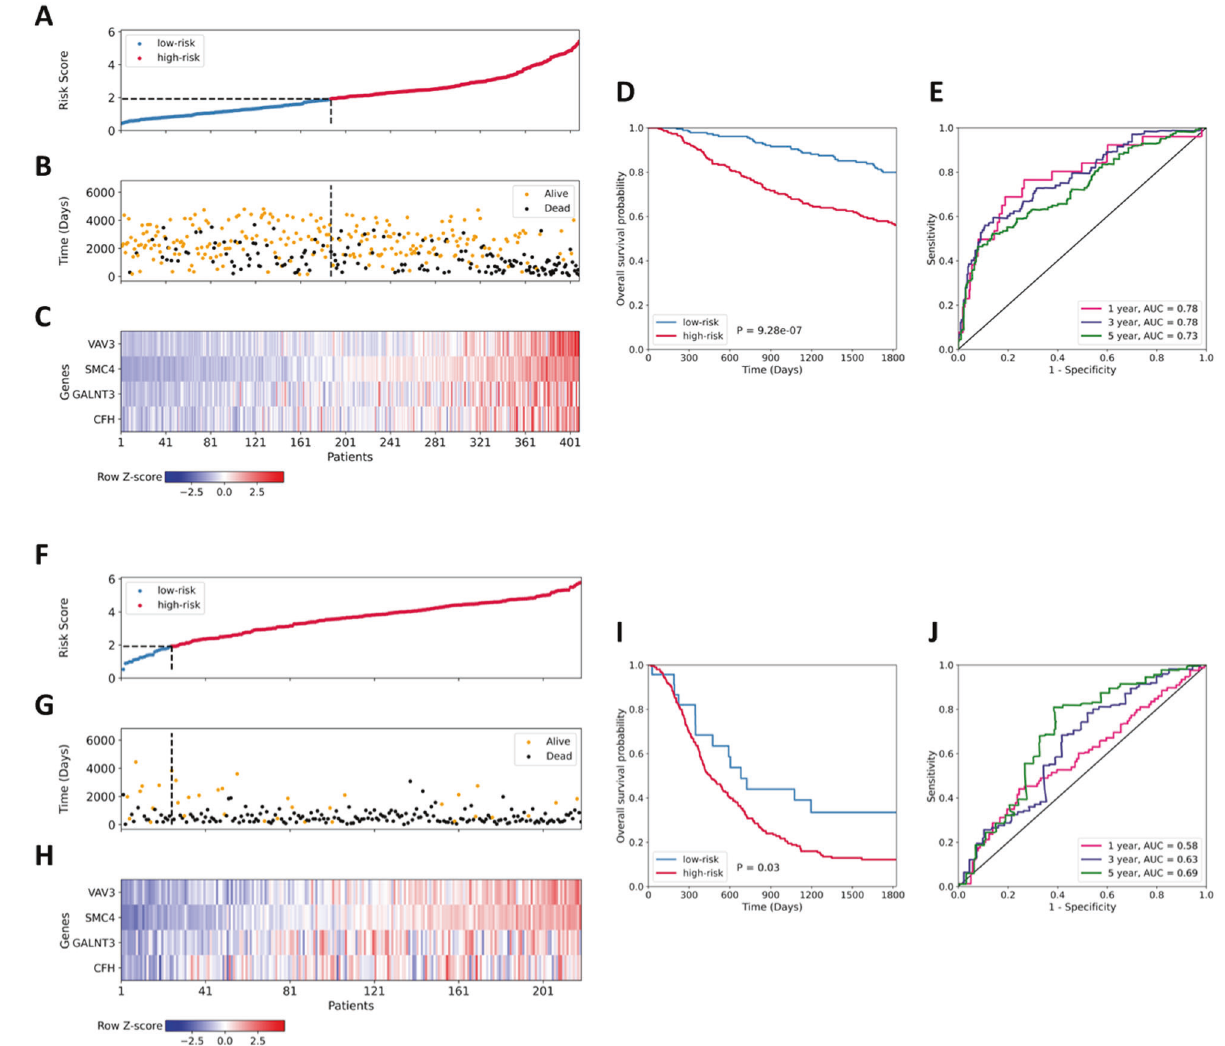
Fig. 7 Validation of the prognostic four-gene signature for overall survival in the CGGA-LGG, TCGA-GBM and CGGA-GBM datasets. A – E Characteristics of the four-gene prognostic signature in the validation CGGA-LGG dataset. A The low- and high-risk scores for each CGGA- LGG patient. B The time to death of patients (black, DEAD) and time until last follow-up of live patients (orange, ALIVE) from the CGGA-LGG dataset. C Heatmap of gene expression pro fi les of the four prognostic genes in the CGGA-LGG dataset. D Kaplan – Meier survival analysis of high-risk versus low-risk groups in the CGGA-LGG dataset. E Time-dependent receiver operating characteristic curve analysis of the four-gene predictive model in the CGGA-LGG dataset. F – J Characteristics of the four-gene prognostic signature in the validation CGGA-GBM dataset. F The low- and high-risk scores of each CGGA-GBM patient. G The time to death of dead patients (black, DEAD) and time until last follow-up of live patients (orange, ALIVE) from the CGGA-GBM dataset. H Heatmap of gene expression pro fi les of the four prognostic genes in the CGGA- GBM dataset. I Kaplan – Meier survival analysis of high-risk versus low-risk groups in the CGGA-GBM dataset. J Time-dependent receiver operating characteristic curve analysis of the four-gene predictive model in the CGGA-GBM